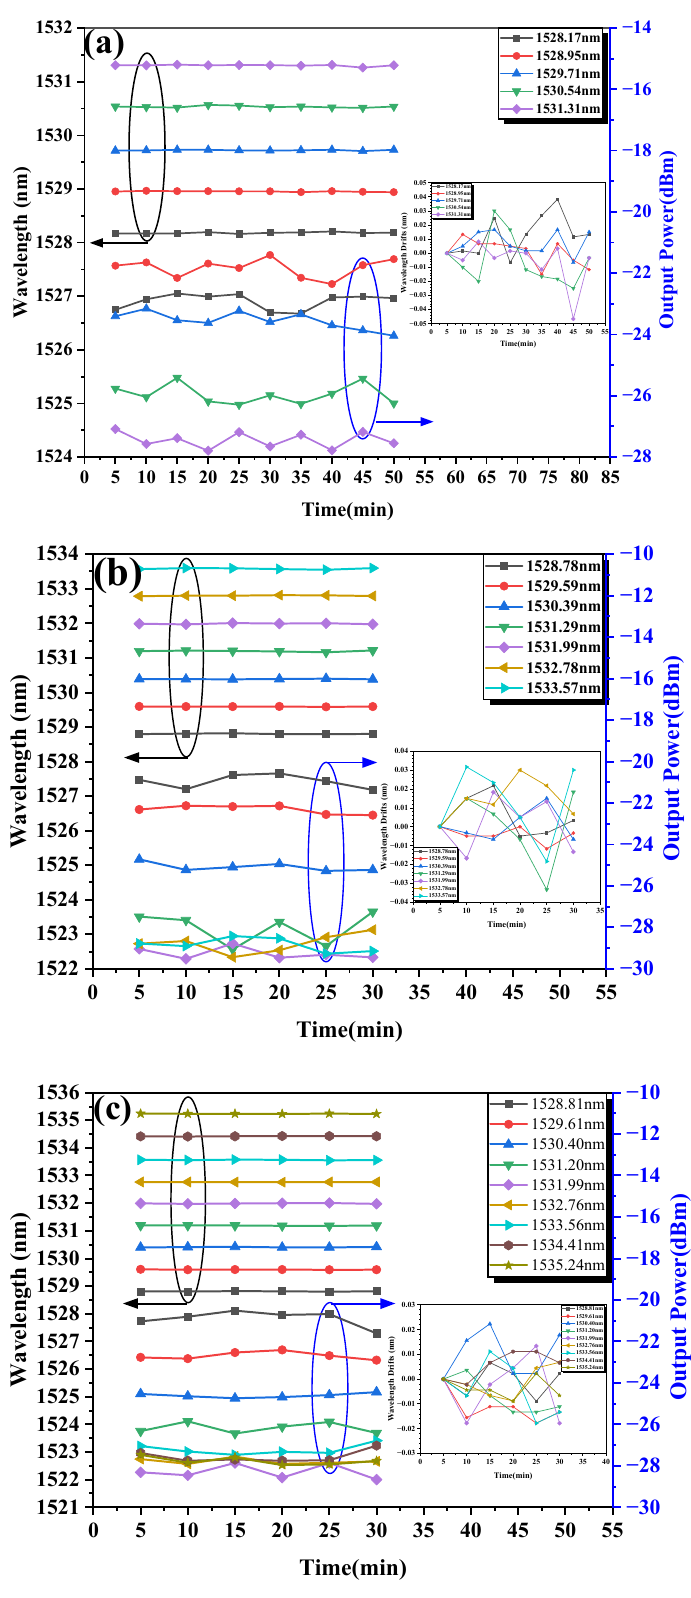
Figure 9. The wavelength drifts (black) and power fluctuations (blue) of ( a ) five wavelengths; ( b ) seven wavelengths; ( c ) nine wavelengths with time interval of five minutes. Inset shows the variation of the wavelength shift with time.